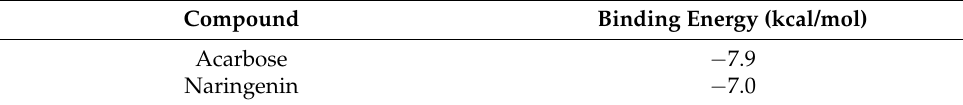
Table 4. Binding energy of acarbose and naringenin with α -glucosidase receptor. Compound Binding Energy (kcal/mol) Acarbose − 7.9 Naringenin − 7.0